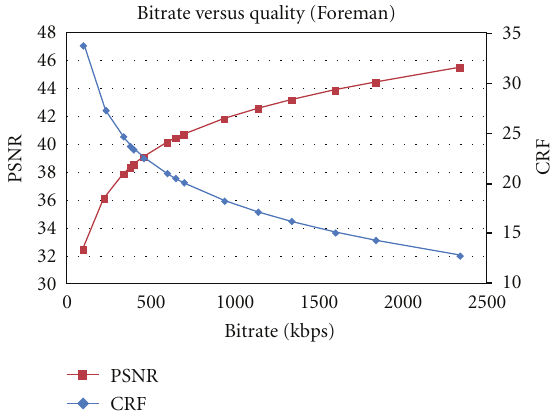
Figure 1: Bitrate versus PSNR and CRF